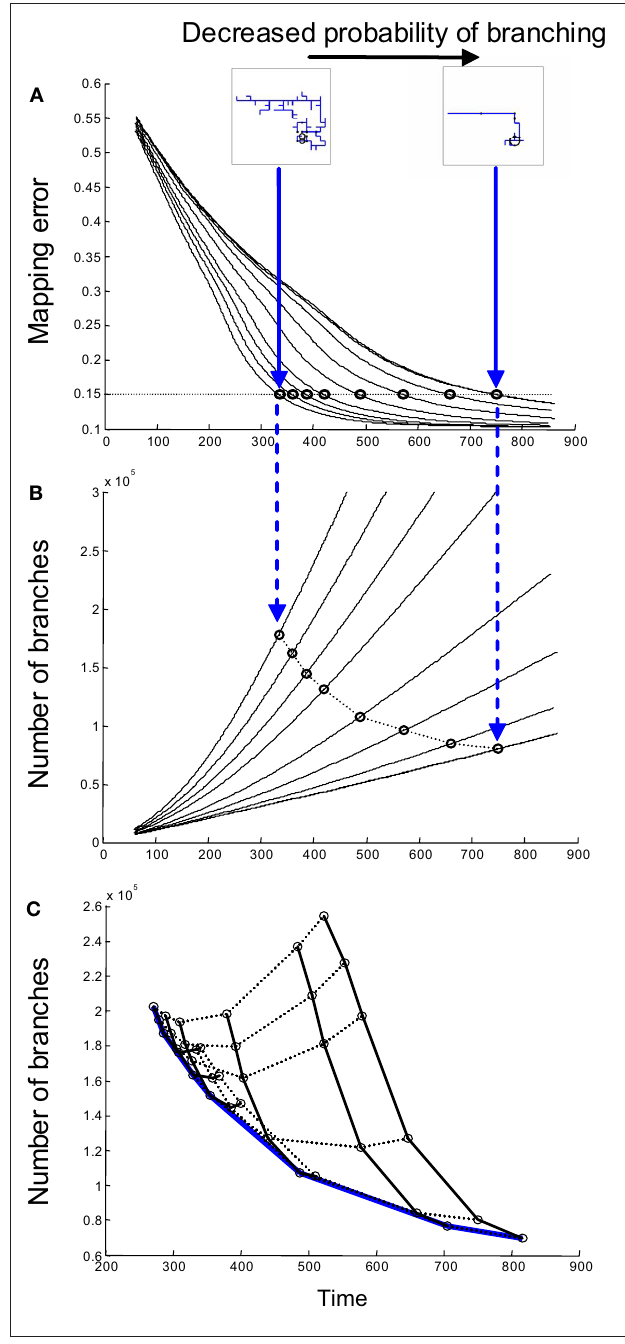
FIGURE 3 | The infl uence of branching on time and material cost. (A) The time-dependence of mapping precision is shown for simulations involving different probabilities of axonal branching when both axons and dendrites use branching Strategy 1. When the probability of branching is low, axons have very few branches; meanwhile, when the probability is high, the axonal arbors are complex (inset). Mapping with the same degree of precision is established faster when the probability of branching is higher. (B) The time-dependence of the number of branches formed is shown for the same set of simulations, as in (A) . Each circle in (B) corresponds to a circle in (A) and shows the time and the number of branches formed when a 15% level of mapping precision is reached. A mapping precision level of 15% implies that the standard deviation of synapse location is 15% of the map size. (C) A set of curves similar to that shown in (B) is obtained when both axonal and dendritic branching probabilities are varied. Points corresponding to the same axon/dendrite branching probabilities are connected by solid/dashed lines. The lower boundary of the collection of these points [blue line in (C) ] gives the performance boundary for this combination of branching strategies used by axons and